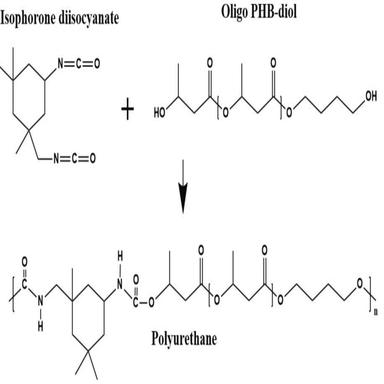
PU synthesis using oligo PHB-diol as a polyol.